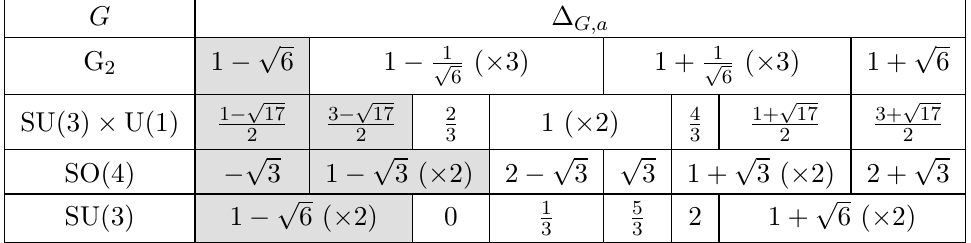
Table 2 . Modes allowed by the BPS equations around each of the supersymmetric AdS 4 solutions labelled by their residual gauge symmetry G . We have ordered them in increasing magnitude and highlighted with a gray background the modes with (cid:1) G;a < 0 which parameterise regular domain- wall solutions ending in the IR ( (cid:26) ! (cid:0)1